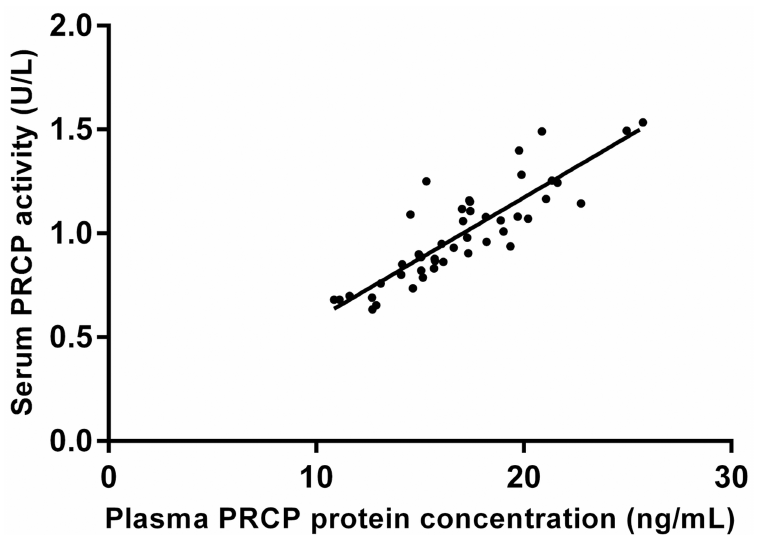
Fig 6. Correlation between serum PRCP activity and plasma PRCP protein concentration. Correlation between serum PRCP activity and plasma PRCP protein concentration in the bariatric surgery group (0.865; p < 0.001, n = 24).